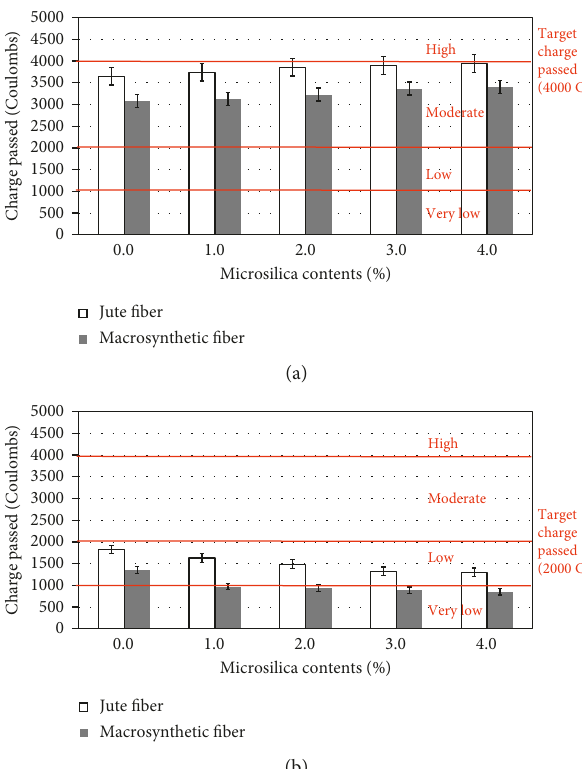
Figure 8: Chloride ion penetration of LMFRCRSC. (a) 4-hour curing. (b) 28-day curing.